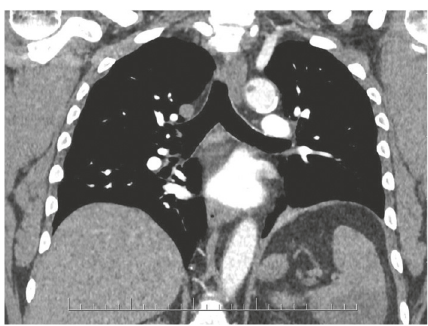
Figure 1: CT angiography showing aortic thrombosis (case no. 1).